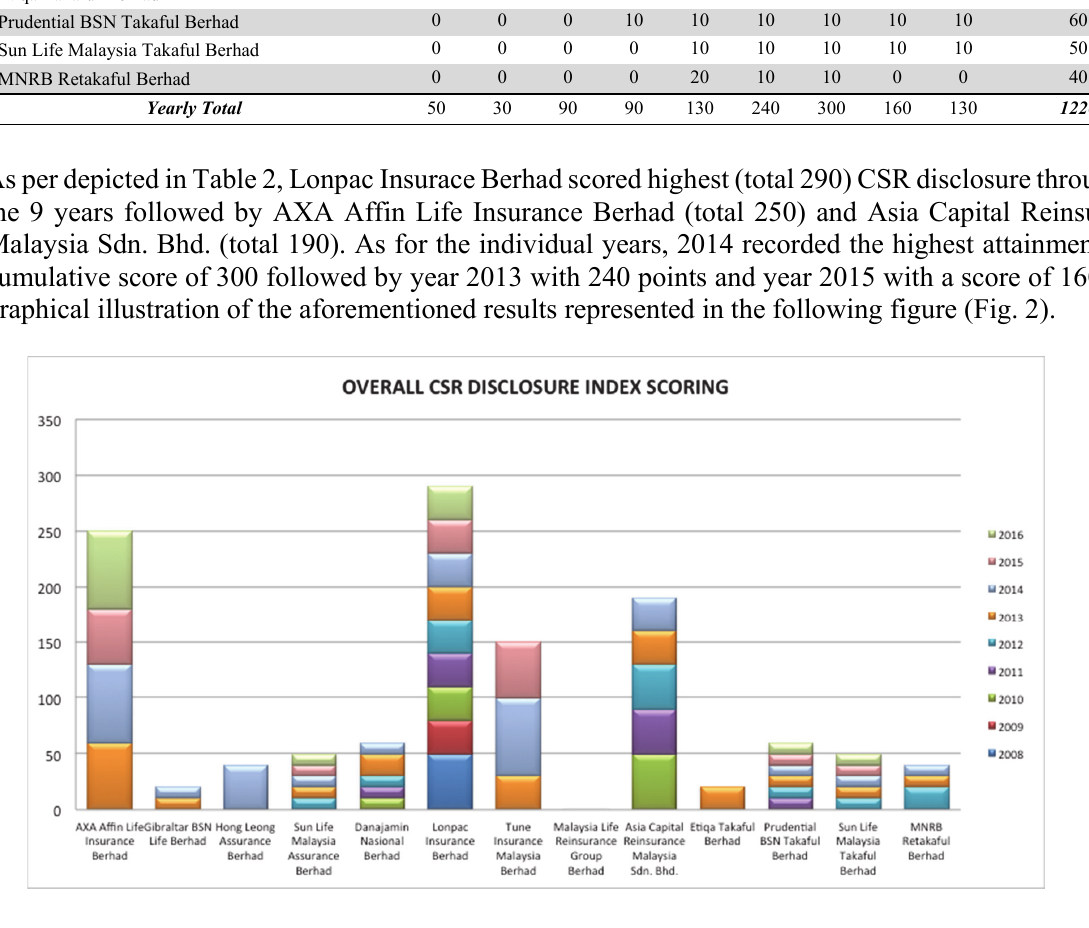
Fig. 2. CSR Disclosure of All Domestic-Owned 13 Insurance